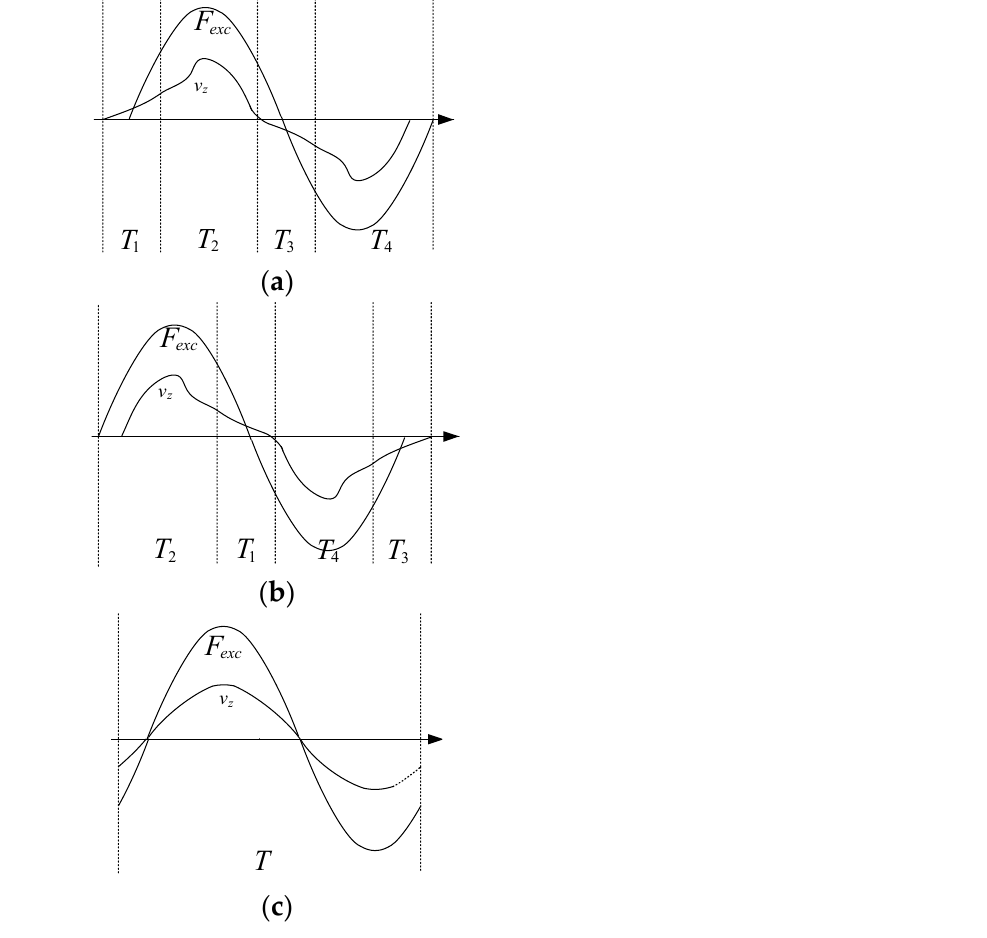
Figure 15. Phase analysis and domain partition of ocean wave power generation system. ( a ) Exciting force F exc legs behind the velocity v z ; ( b ) Exciting force F exc ahead of the velocity; ( c ) Exciting force F exc is identical to the velocity v z .